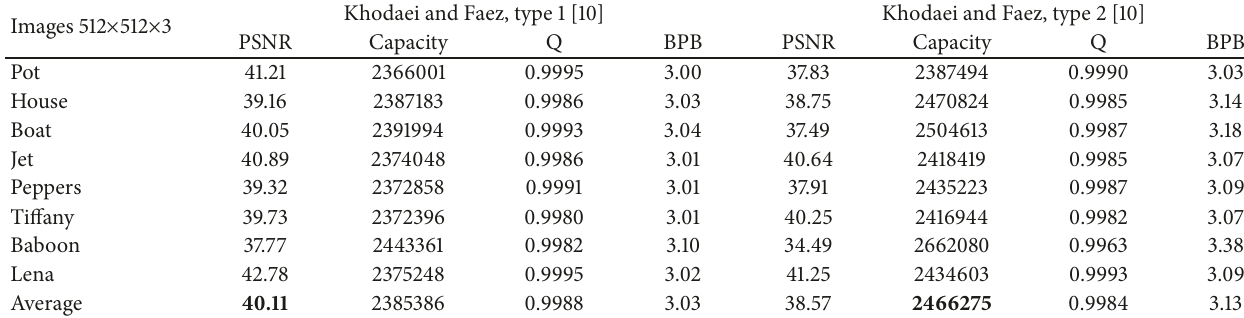
Table 4: Results of Khodaei and Faez’s technique.